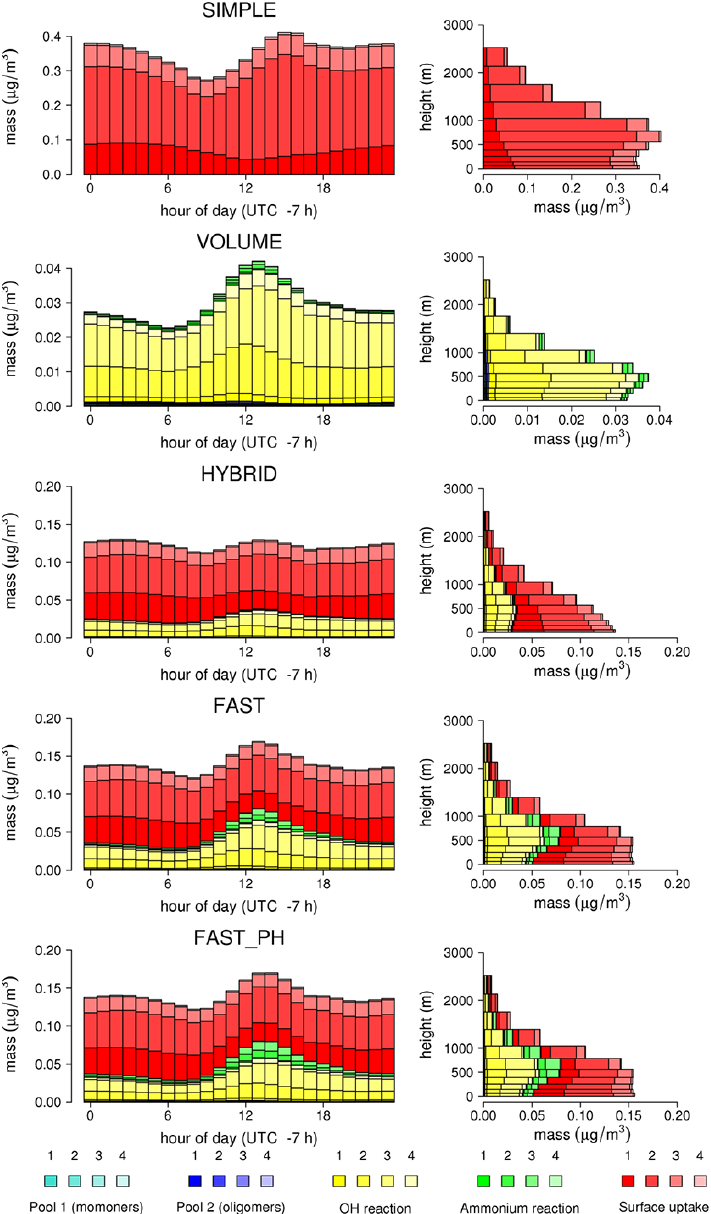
Figure 12. Contributions of different formation pathways to glyoxal-SOA in the LA basin focus region for the different studies given as diurnal cycle in the lowest model layer averaged over the simulation period (left panels), and as average vertical distribution (panels on the right). Size bins start with the smallest (1: 39–156nm, 2: 156–625nm, 3: 625nm–2.5µm, 4: 2.5–10µm). Note the different scales for each